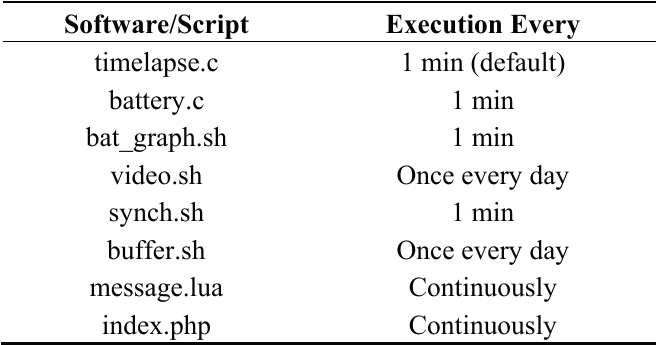
Table 14. Imaging-monitoring system software.